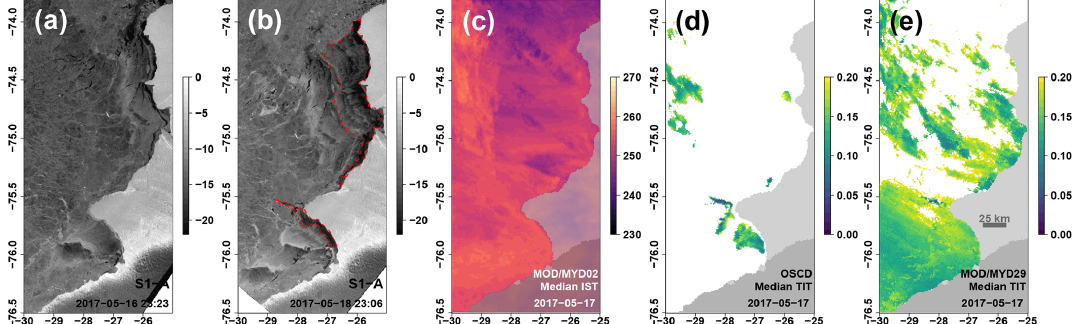
Figure 7. Compilation of S1-A swaths acquired on 16 and 18 May 2017 ( a, b , respectively; calibrated backscatter in dB), the daily median ice-surface temperature (IST; in K) composite for 17 May 2017 from all available MODIS swaths (c) , and the resulting daily median thin-ice thickness (TIT; in m) composites for the OSCD (d) and MOD/MYD29 (e) products for 17 May 2017, respectively. Red dashed line outlines